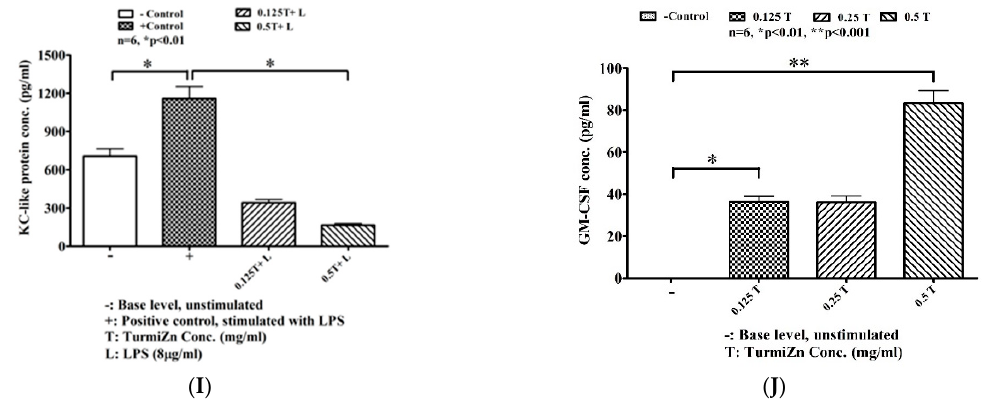
Figure 7. TurmiZn modulates LPS-induced cytokine production in MDCK cells in a dose-dependent manner. ( A ): IL-2 levels; ( B ): IL-8 levels, ( C ): IL-6 levels; ( D ): IL-7 levels ( E ): IL-15 levels; ( F ): IL-18 levels; ( G ): MCP-1 levels; ( H ): TNF levels; ( I ): KC-like protein levels; and (J): GMCSF levels. Values are mean ± standard error of the mean.